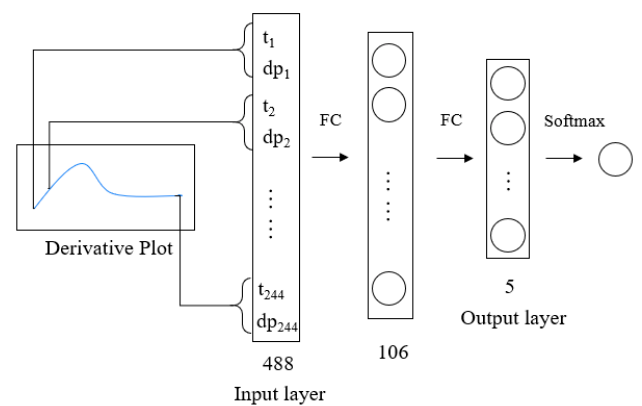
Figure 7. Schematic diagram of fully connected neural networks (FCNN) structure. Table 3. The layer shape and weights number of FCNN.